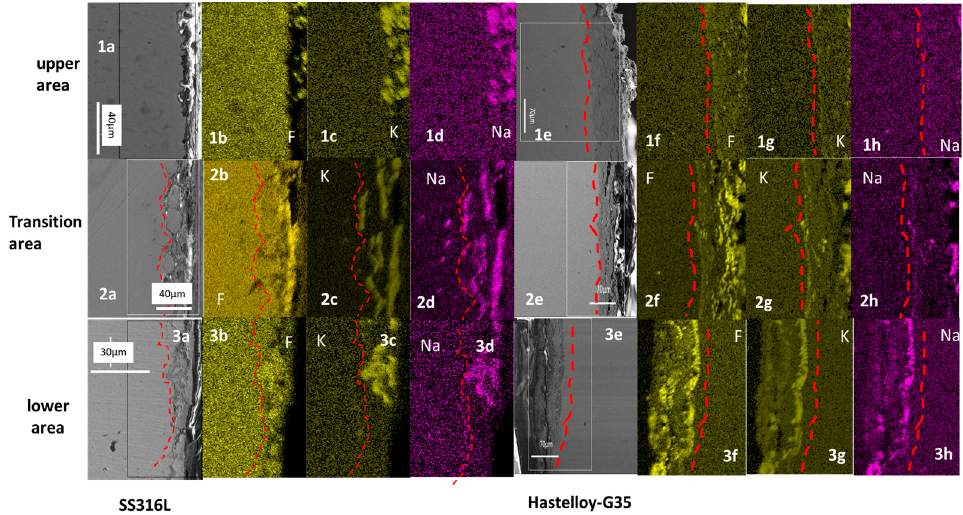
Figure 12. Cross-sectional mapping of the upper area ( 1a – 1d ), transition are ( 2a – 2d ) and lower ( 3a – 3d ) of SS316L.the upper area of ( 1e – 1h ), transition area of ( 2e – 2h ) and lower are of ( 3e – 3h ) ofHas- telloy ® G35 ® areas area shown.